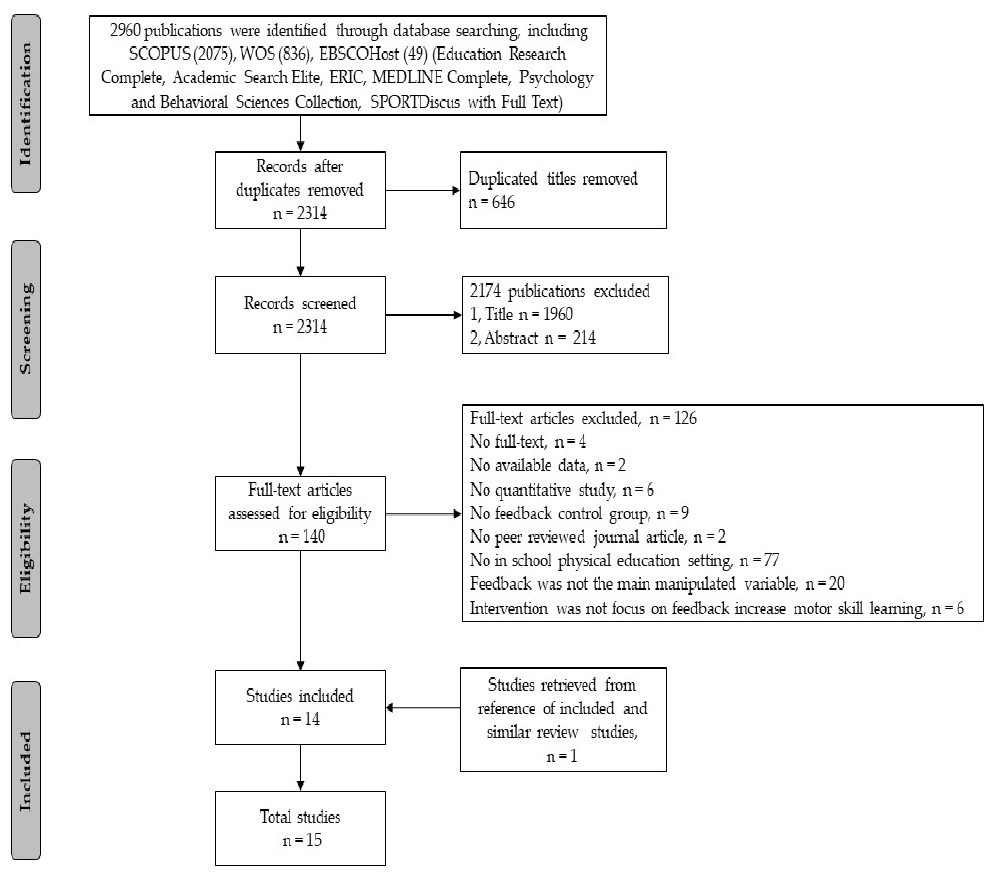
Figure 1. PRISMA flowchart of study selection.